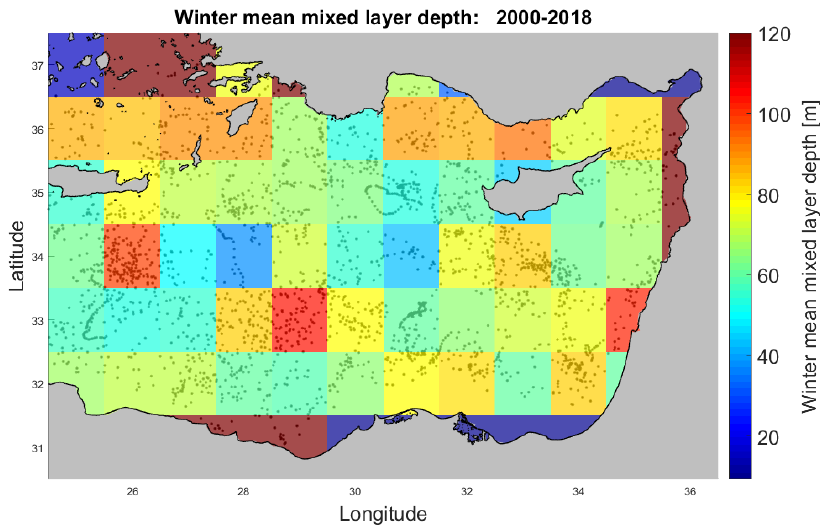
Figure 21. Climatology of the winter (JFM) mean MLD from 2000 to 2018 for the Levantine Sea.